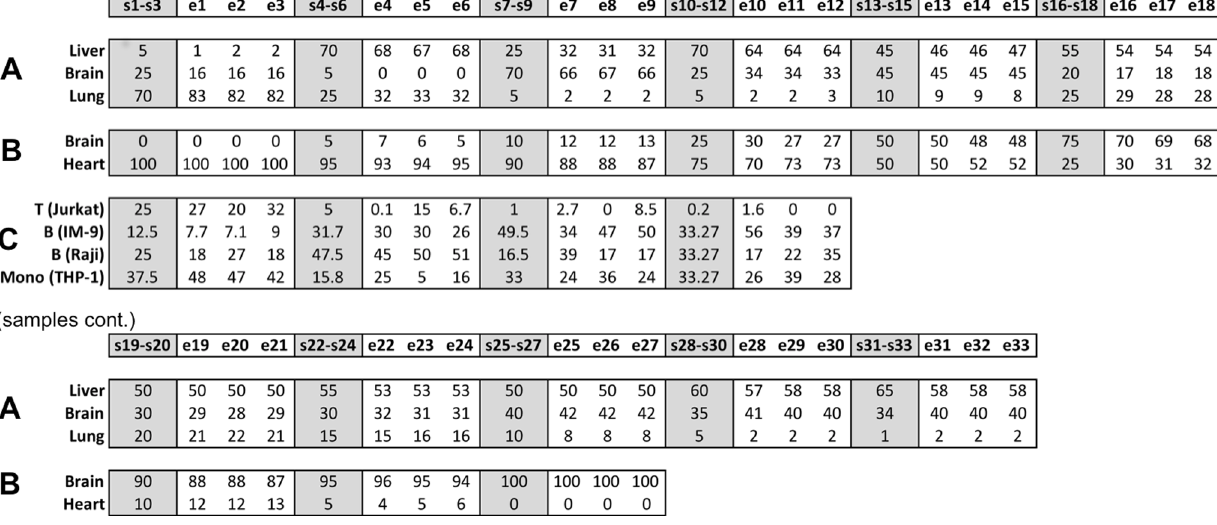
Figure 3. Blind separation yields accurate estimates of cell-type proportions per sample. Comparisons between the known cell-type proportions and the estimated proportions per-sample for cell-types in the controlled datasets. ( A ) The liver-brain-lung dataset [3] included 33 samples, (B) The heart-brain dataset [15] included 27 samples, and ( C ) The T-B-Monocytes dataset [4] included 12 samples. Known proportions are shown in the grey columns, denoted by ‘‘s’’ and were measured as triplicates; estimates yielded by the blind separation algorithm are shown in the white columns and are denoted by ‘‘e’’.